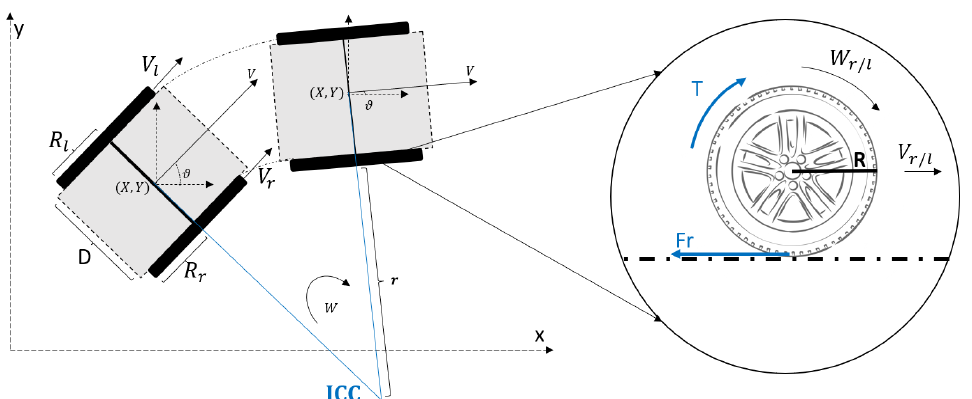
Figure 2. Differential kinematics schema for a mobile